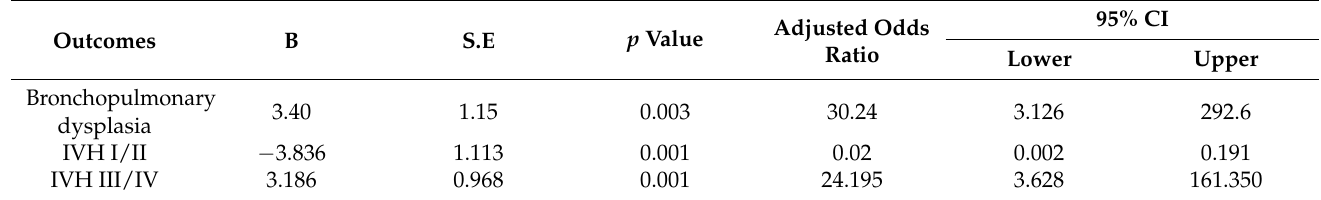
Table 7. Probability of fetal outcomes among infants delivered under 30 weeks in the control group, after adjustment for gestational age at birth.